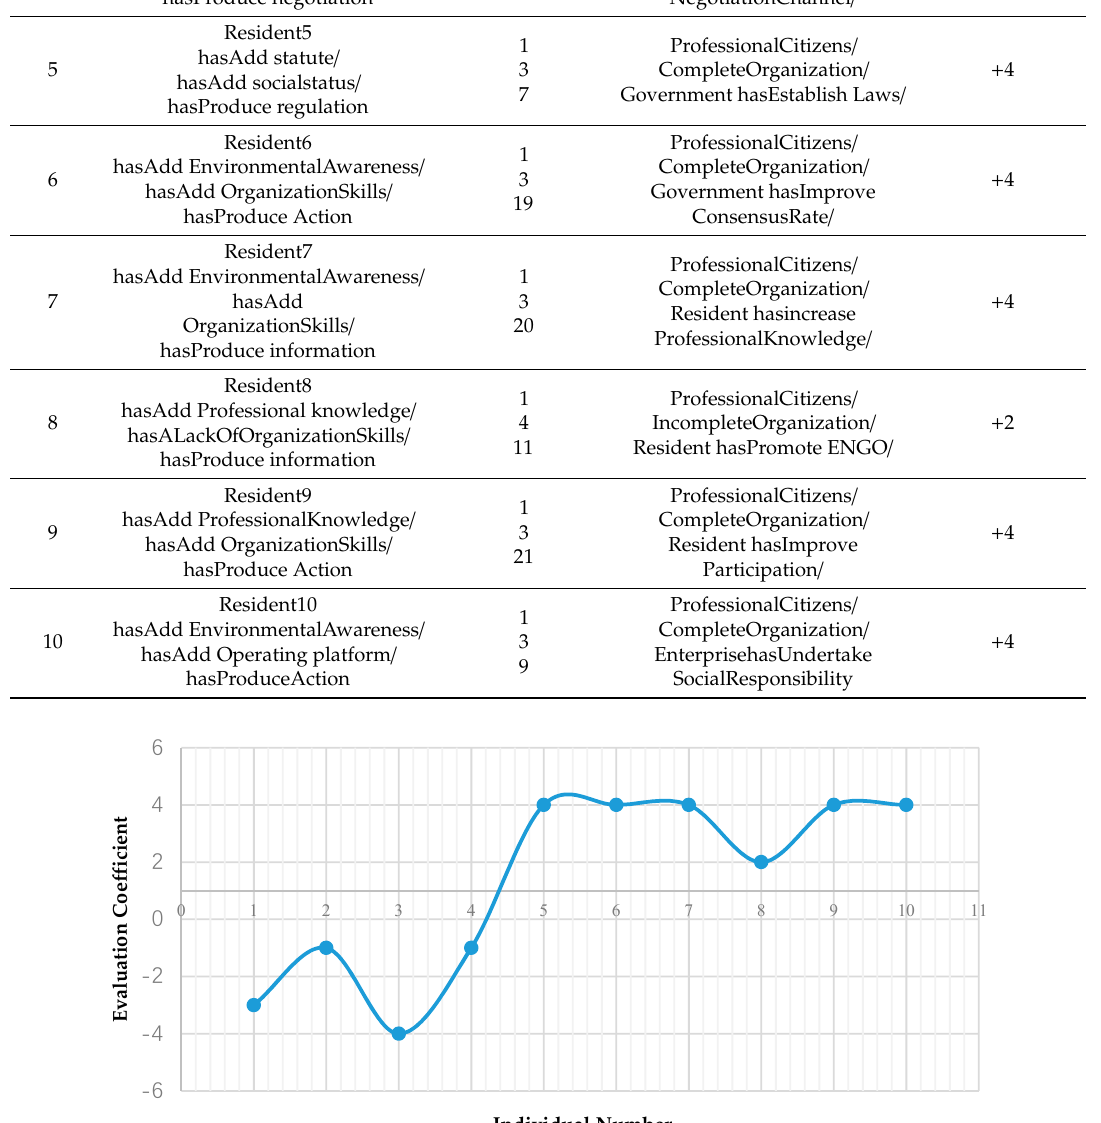
Figure 11. The risk transformation evaluation coefficient curve.